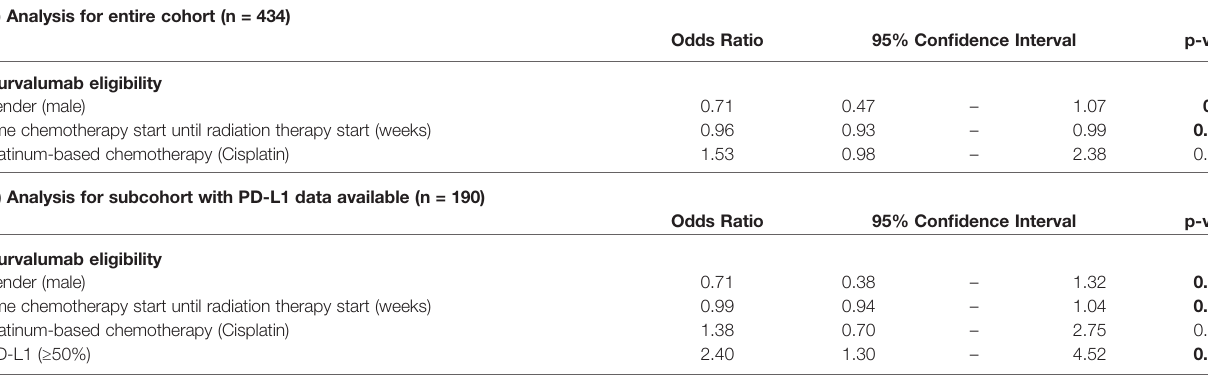
TABLE 4 | Factors signi fi cant in logistic regression analysis and bootstrap analysis for the endpoint of durvalumab eligibility with corresponding odds ratios and p-values. A) Analysis for entire cohort (n = 434)